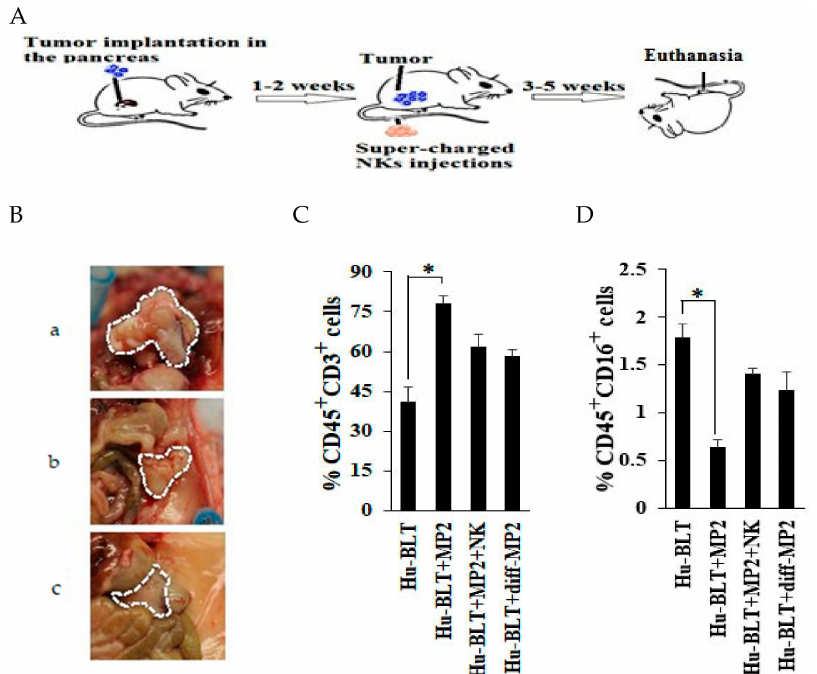
Figure 3. Single injection of super-charged NK cells inhibited tumor growth and increased immune cells in the pancreas in hu-BLT mice. Hu-BLT mice were generated as described in the Materials and Methods section and as depicted in the Figure S2B in Supplementary File, and they were implanted with 1 × 10 6 tumors in the pancreas, and, injected with 1.5 × 10 6 super-charged NK cells via tail vein after one to two weeks ( A ) and disease progression was monitored. After 6–7 weeks mice were euthanized and pictures of the tumors within the pancreas were taken post-mortem in mice injected with tumor in the absence of super-charged NK cells (panel a ), tumor-bearing mice injected with super-charged NK cells (panel b ), and NK-di ff erentiated tumors (panel c ) ( n = 5 / each experimental condition); one representative experiment is shown in the figure ( B ). Pancreas was dissociated as described in the materials and methods section and the single cells (1 × 10 6 cells / ml) were used to determine the percentages of huCD45 + CD3 + ( C ) and huCD45 + CD16 + cells ( D ) ( n = 3 / each experimental